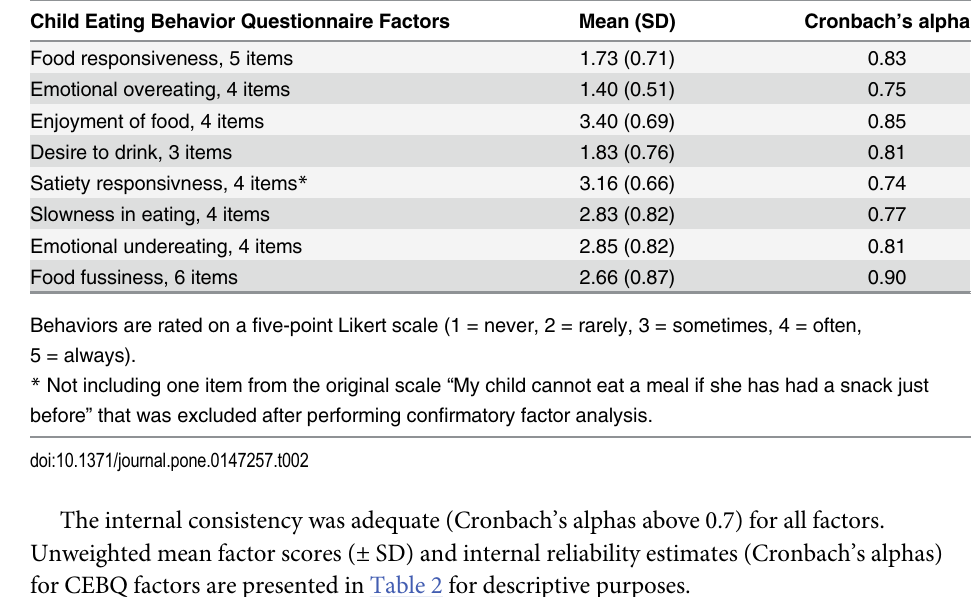
Table 2. Descriptive statistics and Cronbach ’ s alphas for each